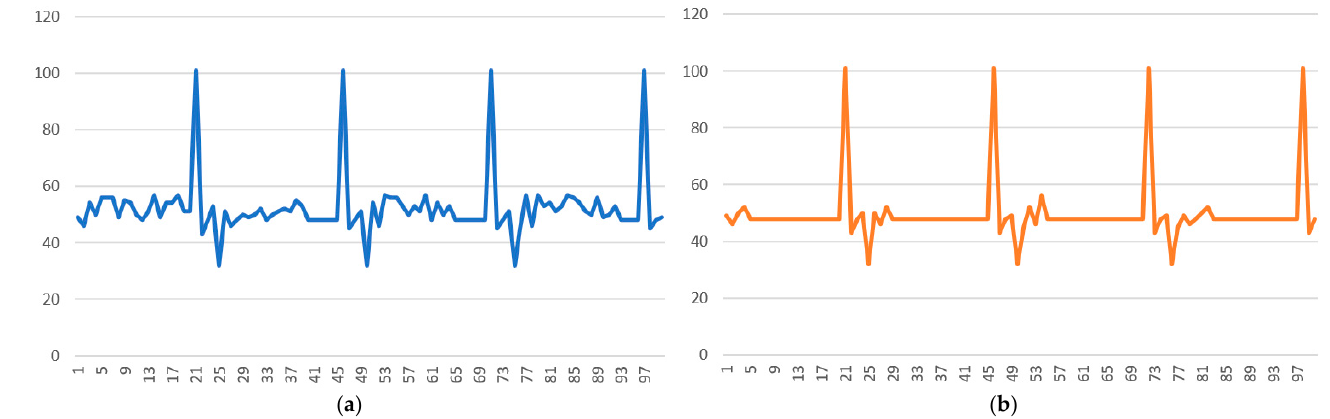
Figure 3. Samples of accelerometer readings. ( a ) Phone accelerometer (walking). ( b ) Watch accelerometer (walking).